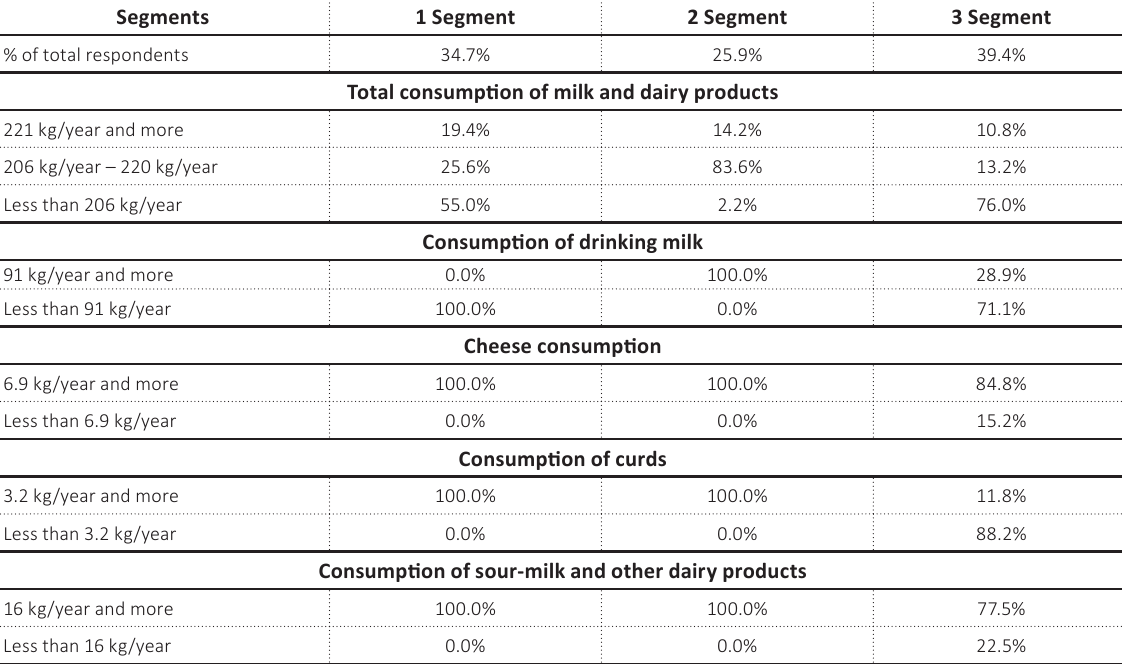
Table A3. Consumption of milk and dairy products in individual